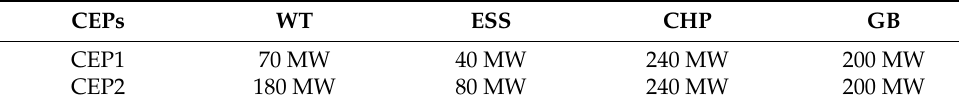
Table 2. The parameters of each device in